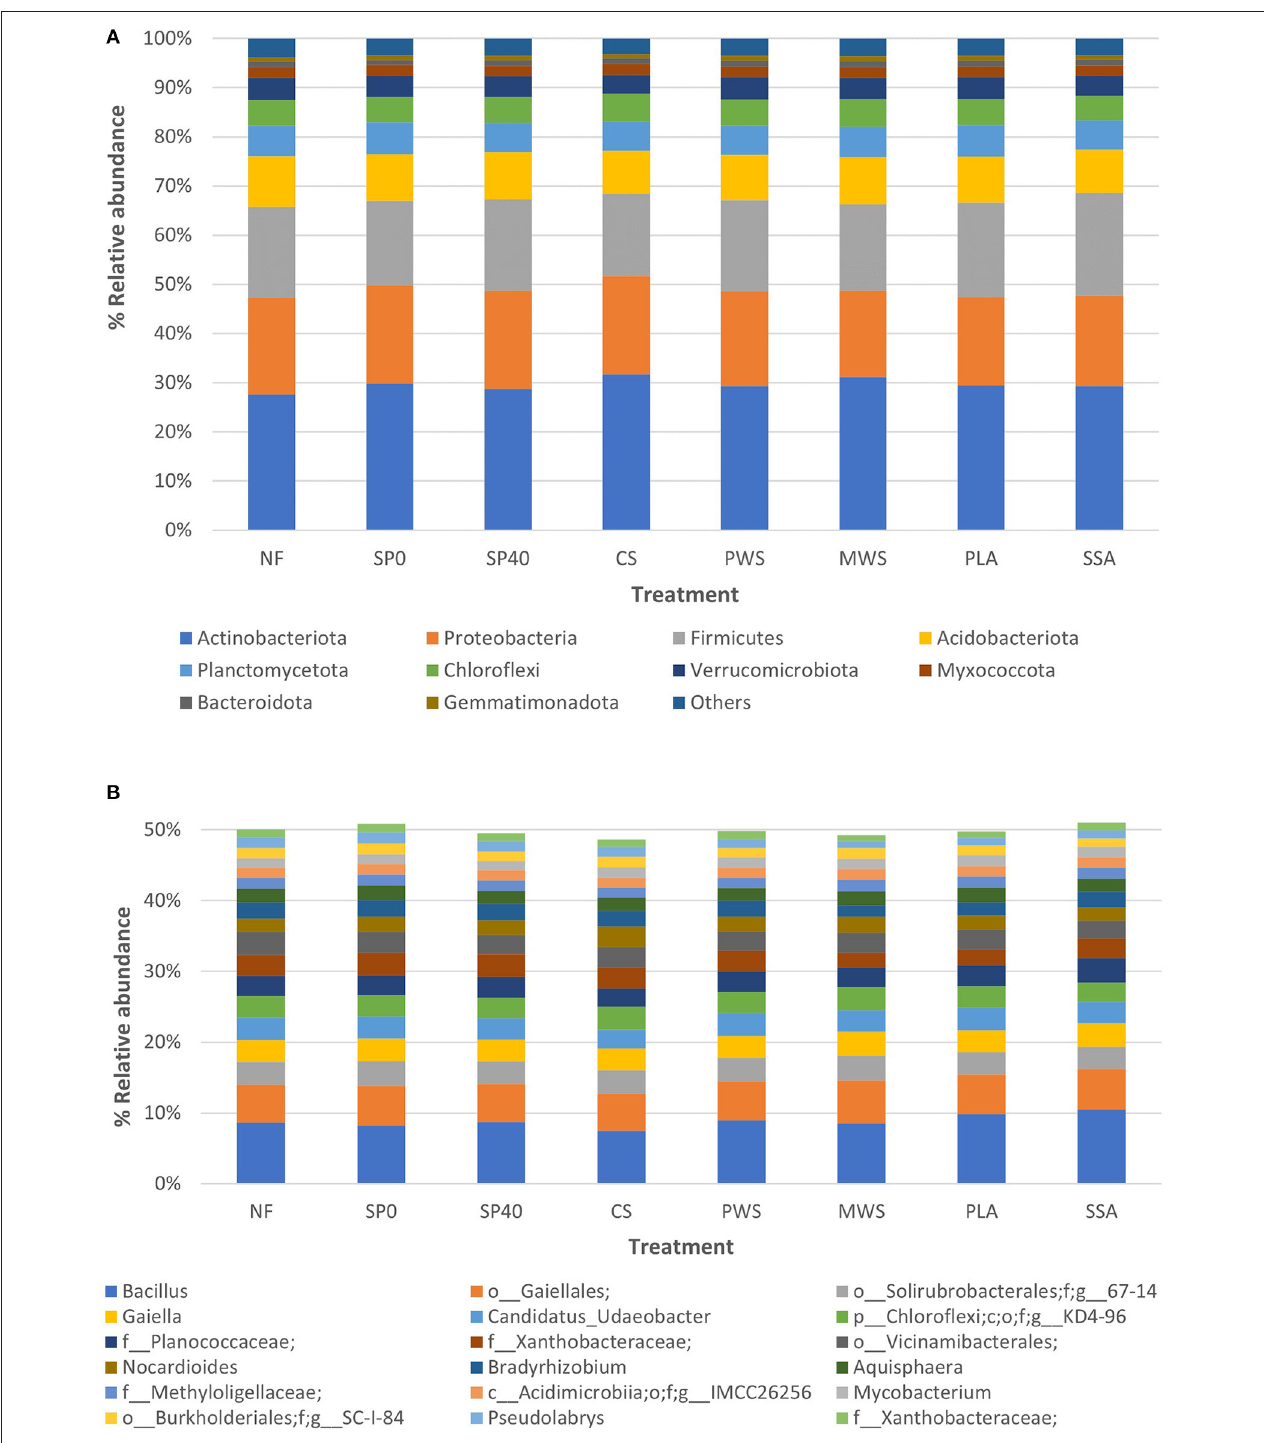
FIGURE 1 | The average relative abundances of (A) the top 10 bacterial phyla and (B) the core bacterial genera, observed in each of the treatment groups ( n = 5). Treatment group name: NF, No fertilizer; SP0, No phosphate; SP40, mineral super phosphate; CS, cattle slurry; PWS, potato waste struvite; MWS, municipal waste struvite; PLA, poultry litter ash; SSA, sewage sludge